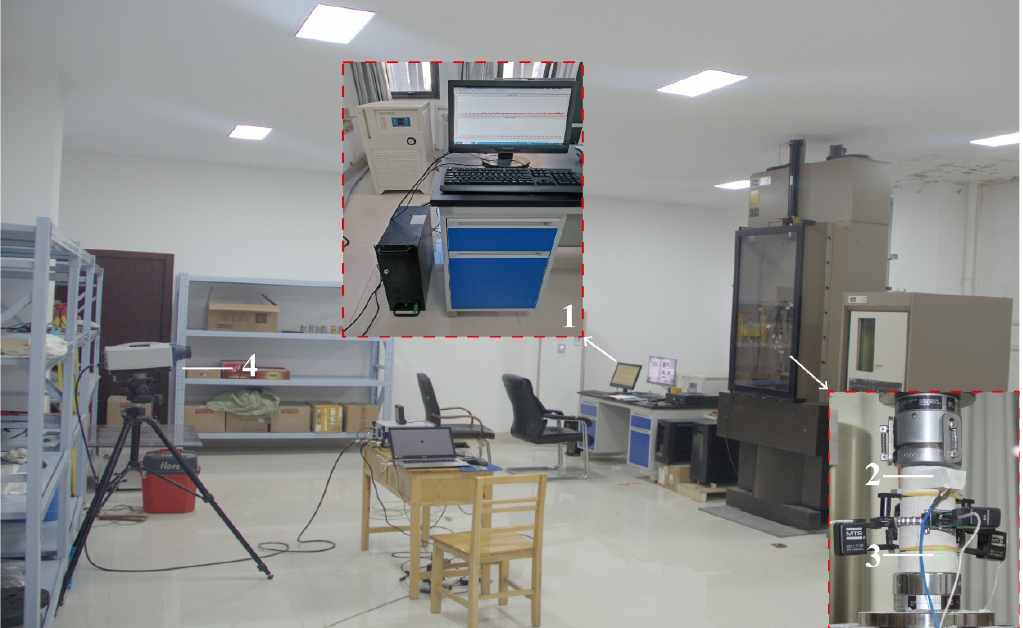
Figure 4. Testing site: 1—the AE system; 2—the AE sensor; 3—the LDV measurement point; and 4—the LDV.